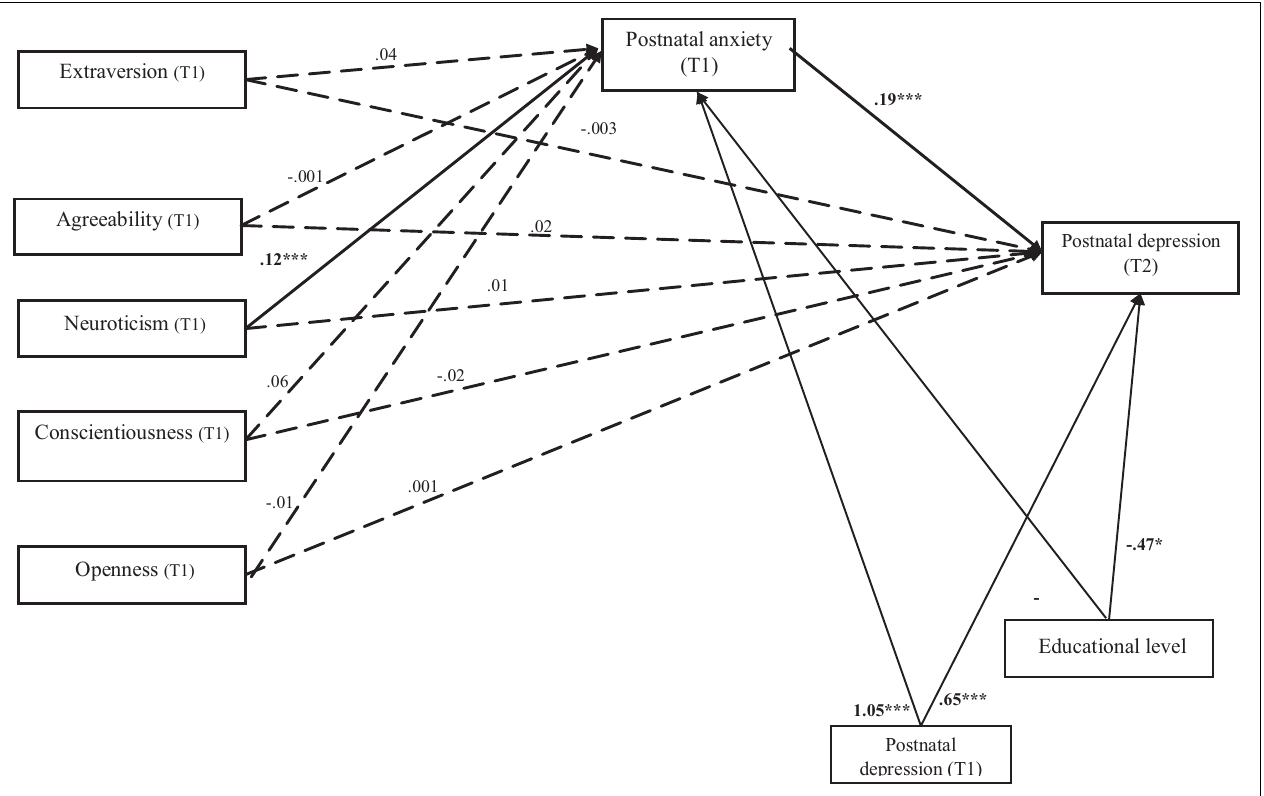
FIGURE 1 | Unstandardized path estimates of the mediation model. The continuous lines indicate statistically significant relations and the dotted lines indicate non-significant relations between constructs. ∗ p < 0.05; ∗∗ p < 0.01; ∗∗∗ p < 0.001.